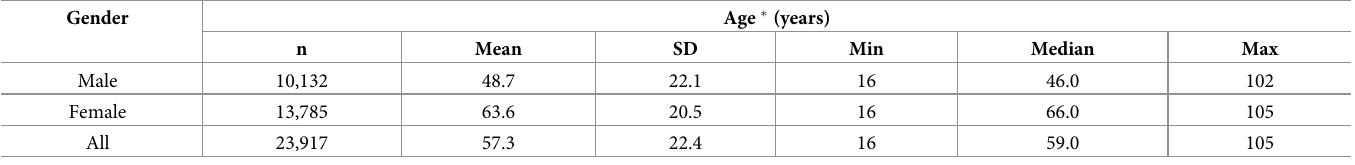
Table 1. Descriptive statistics of gender and age for all sustained